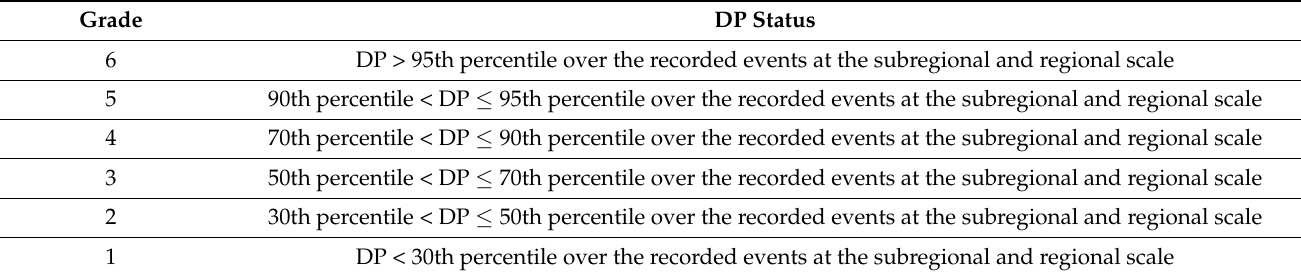
Table 2. Drought parameters classes allocated to each drought event and their competent